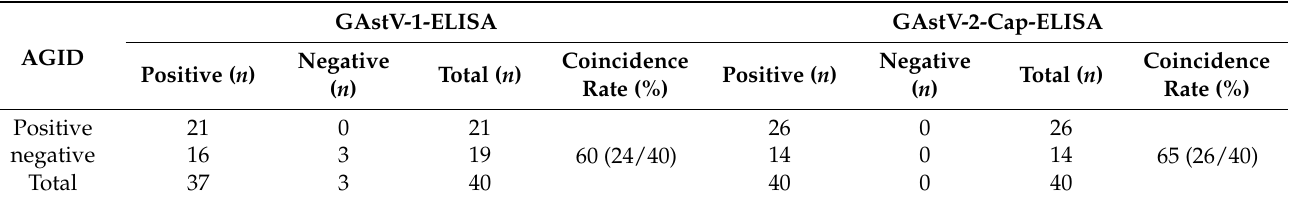
Table 3. Comparison of indirect ELISAs and AGID assay.